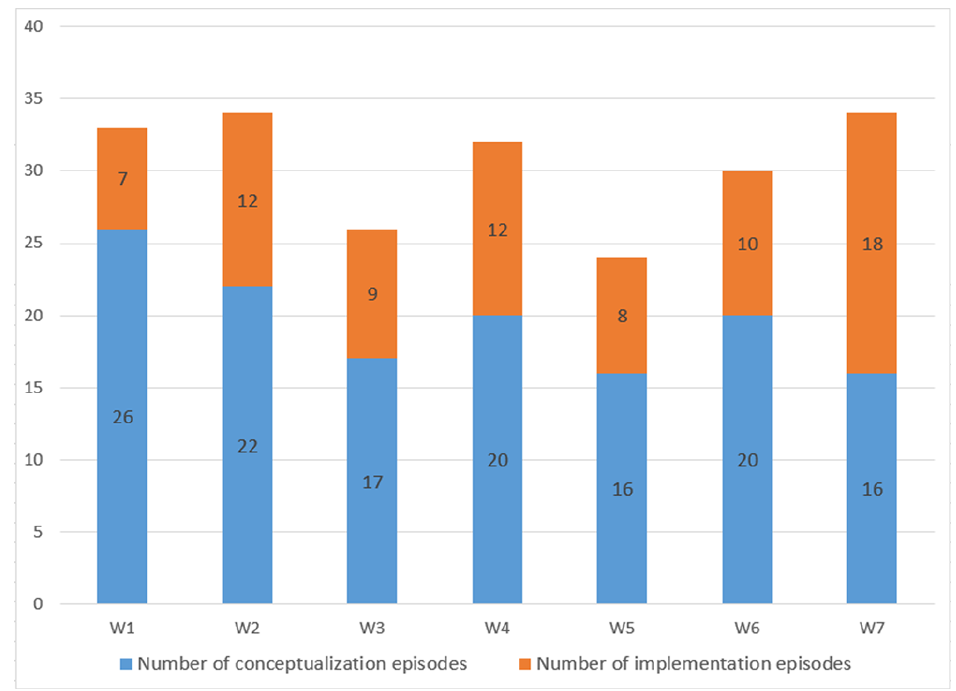
Figure 6. Number of conceptualisation and implementation episodes across